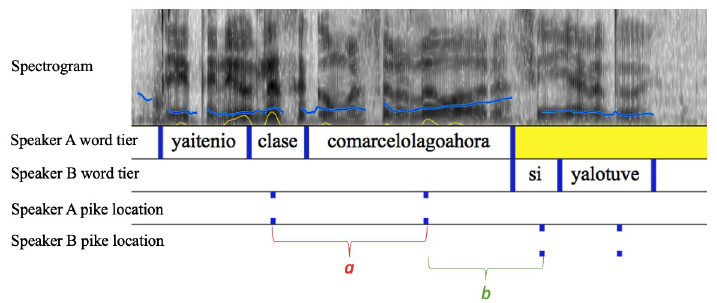
Fig 1. Screenshot of a Q+A pair set up in Praat. Top panel: spectrogram of both talkers’ speech (0–500 Hz), with speakers’ f0 contour (blue) and intensity contour (yellow) superimposed. Next two panels: speaker A and speaker B’s words, on separate tiers. (The compressed time scale means that the word abuela has been truncated to abue .) Lowest two panels: speaker A’s and speaker B’s pikes. The red letters a , b , c and d at the bottom of the figure denote the four (pike-to-pike) time intervals between the five pikes in the Q. The green letter e denotes the interval between the last pike of the Q and the first one in the A (across the turn space). The total duration of the speech displayed is 2.9 s.